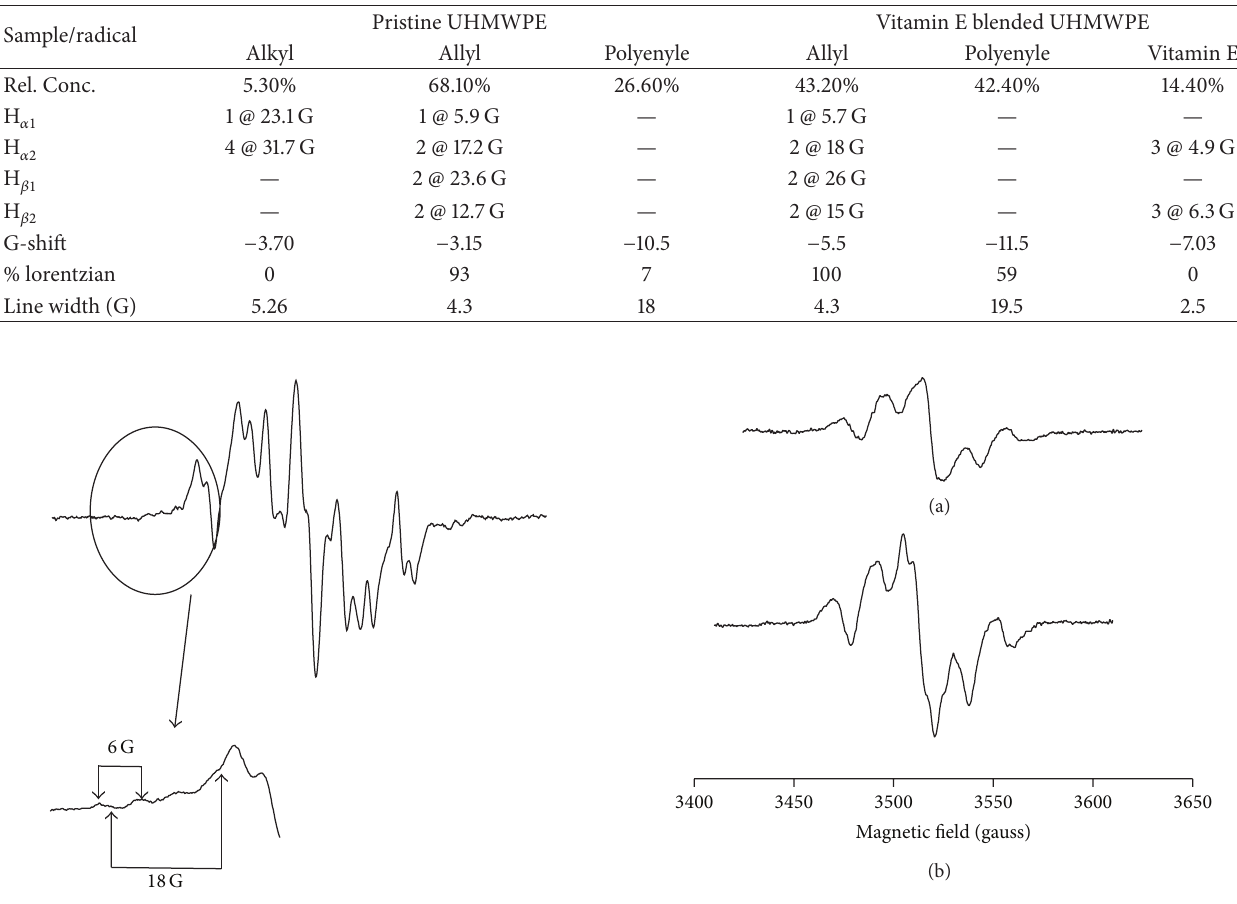
Figure 4: (a) ESR spectra of 100-kGy irradiated sample at 0.01mW microwave power. (b) The right most portion of the spectrum is shown with line separations.